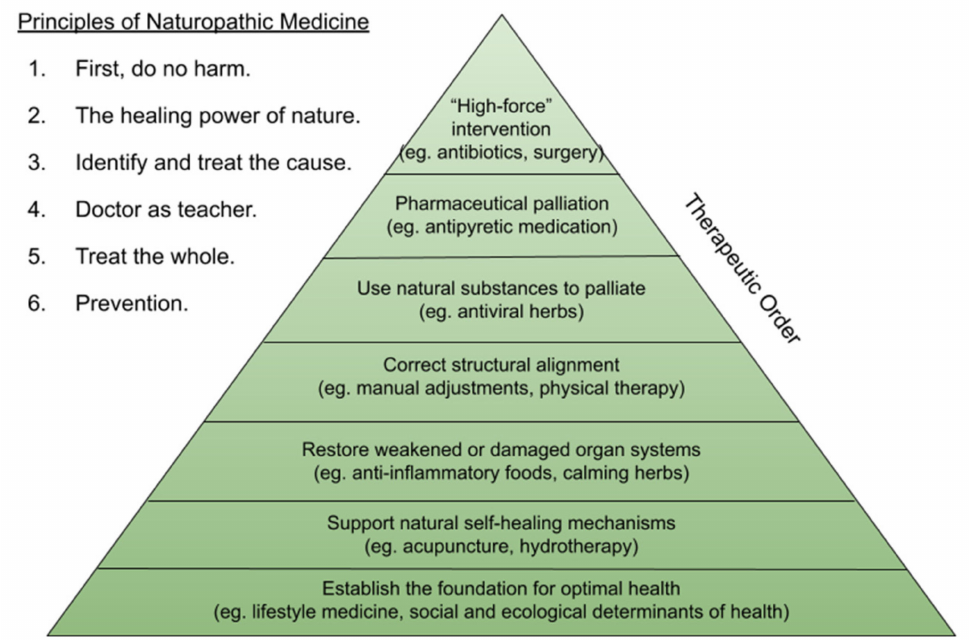
Figure 1. The six principles of naturopathic medicine act as a set of guidelines to inform decision making for holistic care. Therapeutic order is a framework to which these principles are